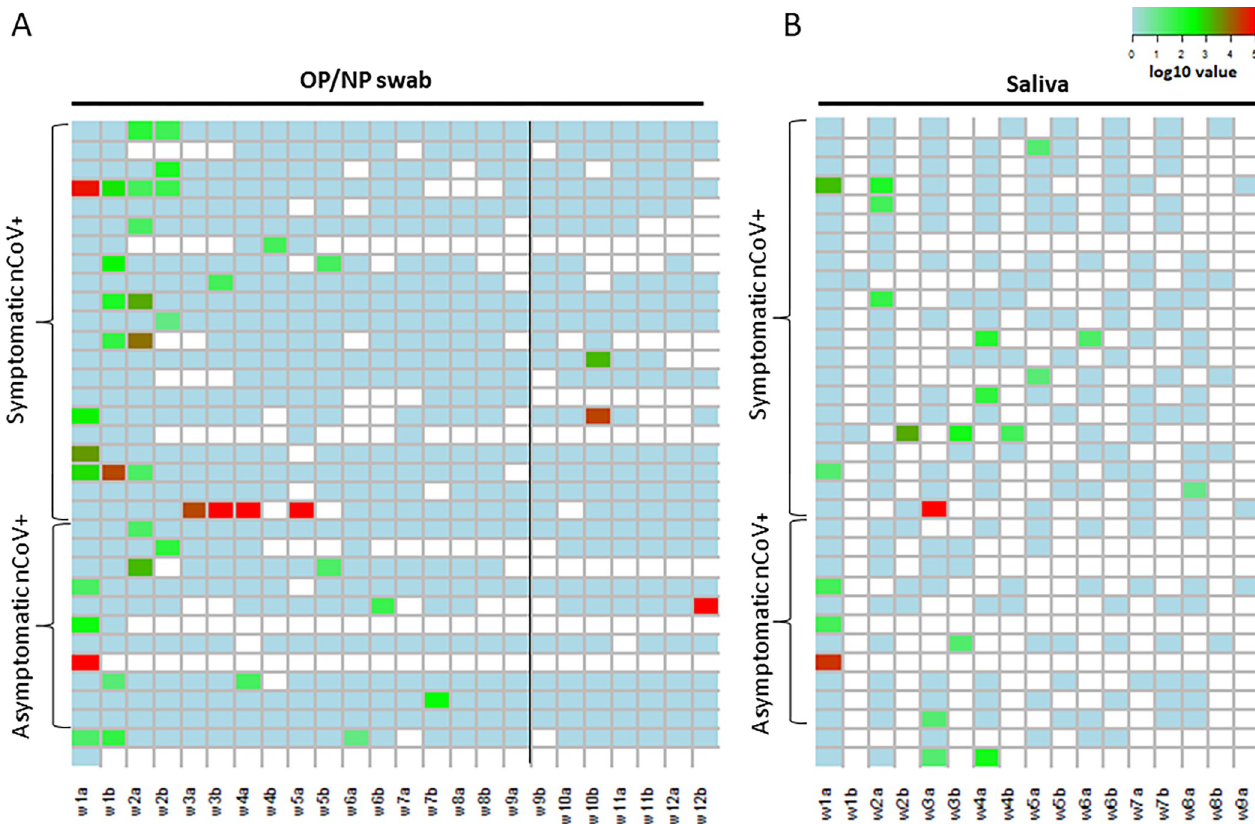
Fig 2. SARS-CoV-2 RNA detection by saliva and combined oropharyngeal/nasopharyngeal sample during study period. Timing of SARS-CoV-2 positivity by combined oropharyngeal/nasopharyngeal (OP/NP) and saliva samples over a period of 12- and 8-weeks, respectively, in SARS-COV-2 RNA positive (nCoV +) participants, clustered by symptom status across duration of study (symptomatic or asymptomatic). First and second samples per week are labelled “a” and “b”, respectively. A) Heatmap of log10 viral load value per OP/NP swab sample over surveillance period of 12 weeks (n = 25 nCoV+ by OP/NP swab: 15 symptomatic and 10 asymptomatic). B) Heatmap of log10 viral load value per saliva sample over the sampling period of 8 weeks (n = 17 nCoV+: 11 symptomatic and 6 asymptomatic). For two participants, insufficient symptom information was available to categorise as symptomatic or asymptomatic.